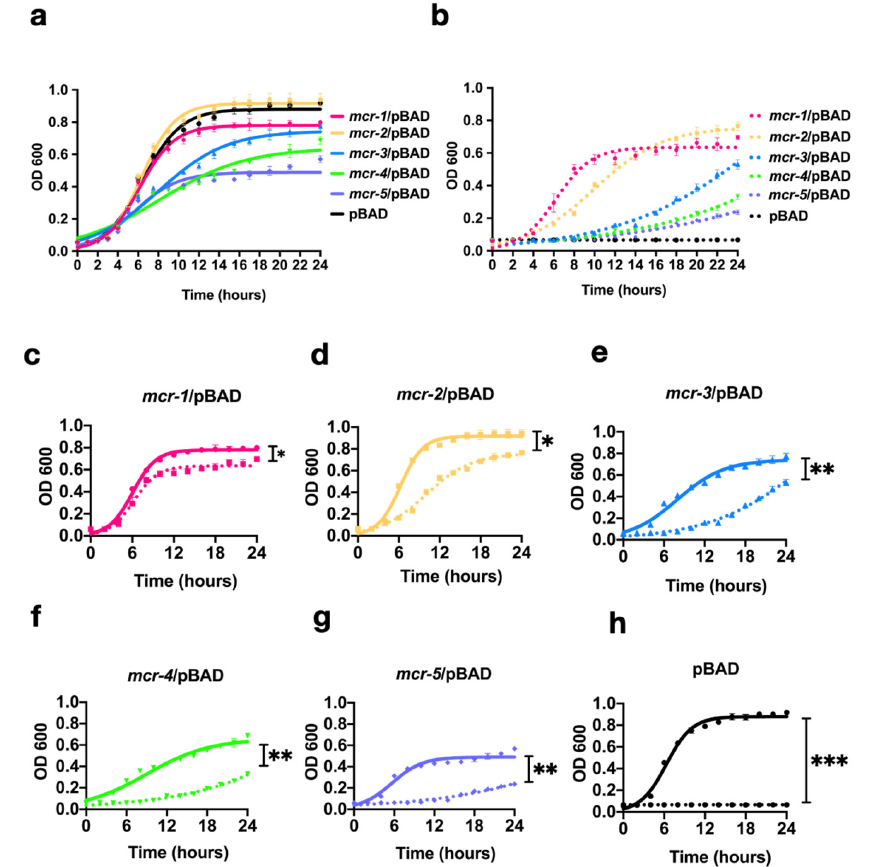
Figure 2. Growth kinetics of MCR-expressing strains in the presence or absence of 0.5 mg/L colistin in broth. ( a ) Growth kinetics of bacteria without colistin and ( b ) with 1 mg/L colistin added to the medium. ( c – h ) Comparisons of each MCR-expressing strain with or without colistin added to the medium. Solid lines represent the absence of colistin; dashed lines represent addition of colistin to the medium. * p < 0.05, ** p < 0.01, *** p < 0.001.